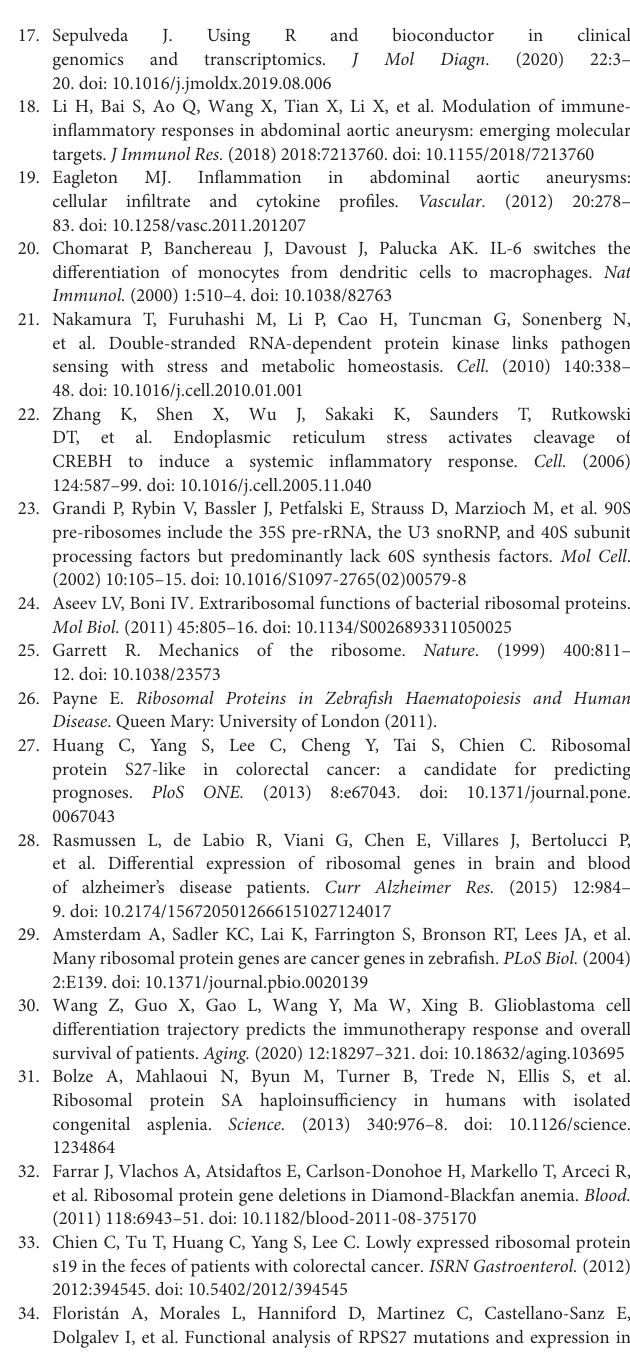
Supplementary Figure 1 | Normalize the merged GSE47472 and GSE57691 chip data in the GEO database. Supplementary Table 1 | The value of differential gene expression analysis results. Supplementary Table 2 | The most significant modules from the PPI network in the up and down regulation